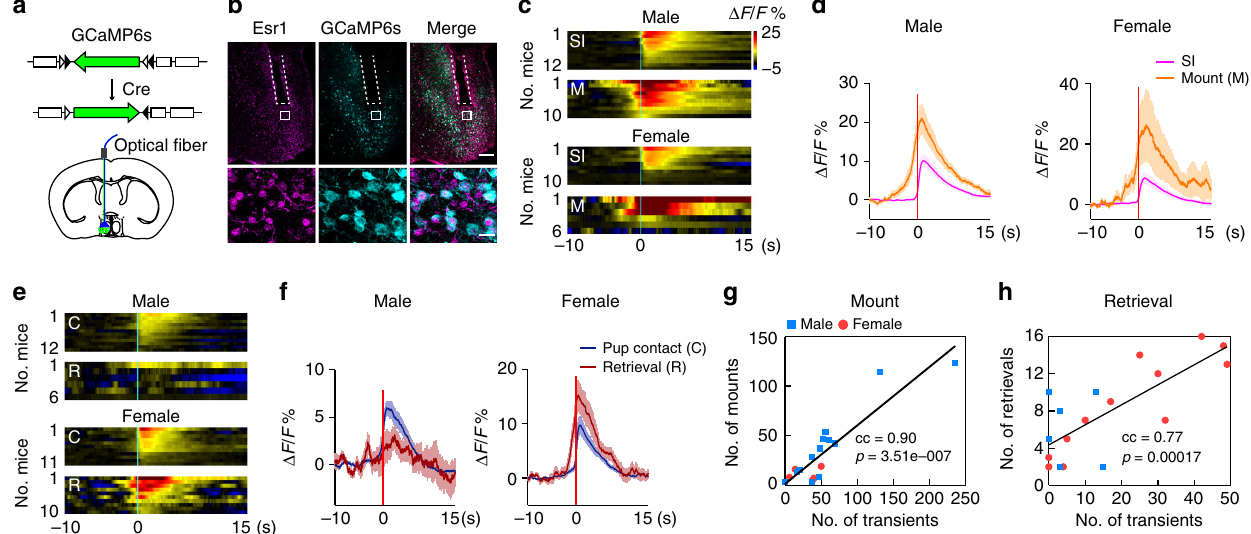
Fig. 5 Neural dynamics of mPOA Esr1 + neurons during social behaviors. a Schematics of the strategy to record activities of Esr1 + neurons. b Example images showing co-localization of GCaMP6s and Esr1 signals. Images on the bottom are blowups of the corresponding white squares in the images on the top. Dashed lines show the placement of the optic fi ber. Scale bar represents 200 μ m for images on the top and 20 μ m for images at the bottom. c – f Heat map plots ( c , e ) and quanti fi cation ( d , f ) of Δ F / F signals around events of social investigations (SI) and mount (M) in male and female Esr1 Cre GCaMP6s animals during social interactions with a female or around events of pup contacts (C) and pup retrieval (R) during interactions with scattered pups, with time “ 0 ” aligned to the onset of behaviors. Scale bar in c applies to all heat maps in this fi gure. In d and f , lines indicate the mean and the shaded area the s. e.m. N = 12 males and 11 females. g , h Signi fi cant correlation between total number of Ca 2+ transients in mPOA Esr1 + neurons and the total number of mount ( g ) and retrieval ( h ) between the fi rst and last behavior in a trial. Mount, N = 13 trials for males and 5 trials for females; retrieval, N = 6 trials for males and 12 trials for females. Pearson ’ s